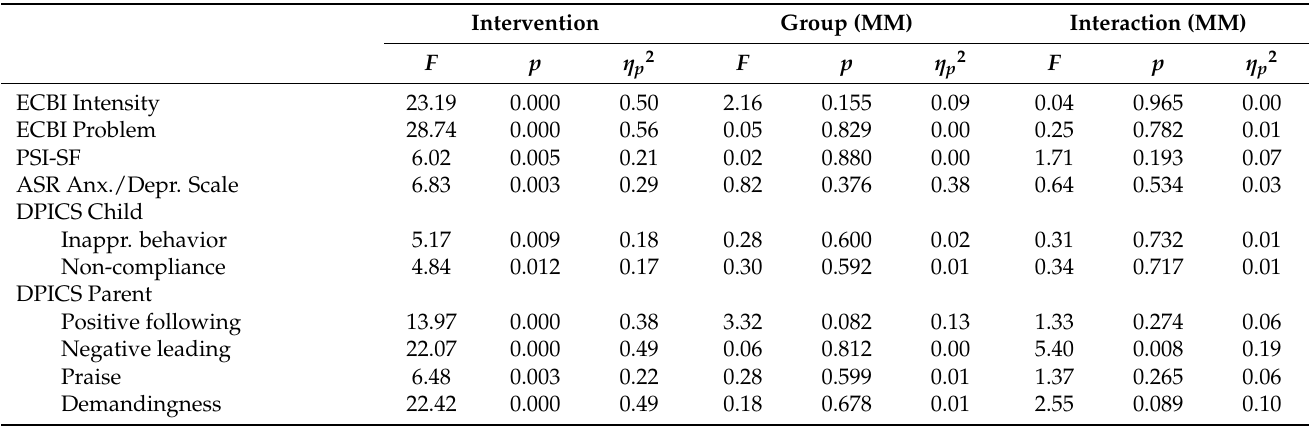
Table 3. PCIT-Clinic repeated measures ANOVA results ( F -values, p , partial eta squared ( η p 2 )).